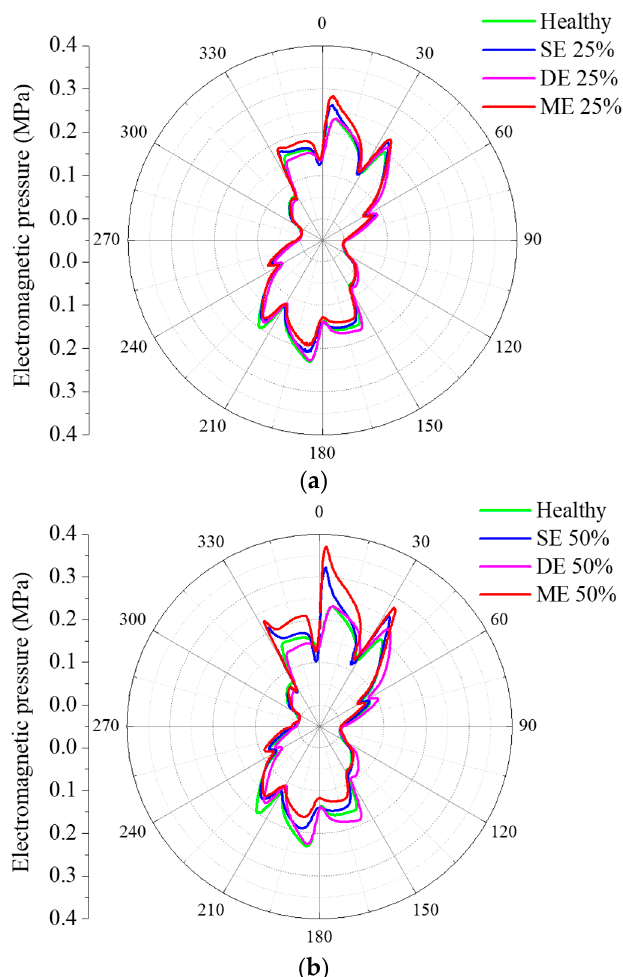
Figure 5. Electromagnetic pressure in the radial direction according to the amount of eccentricity: ( a ) Eccentricity 25% and ( b ) Eccentricity 50%.